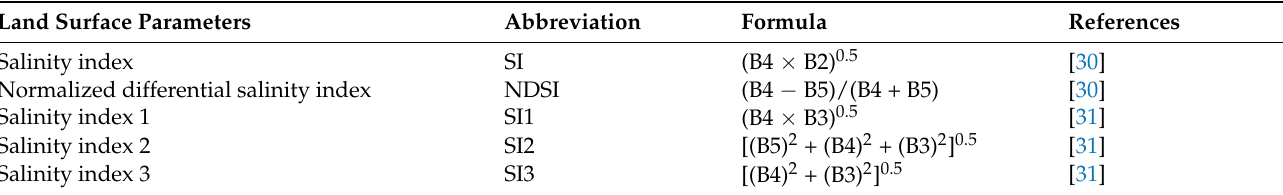
Table 1. Salinity indexes required for the